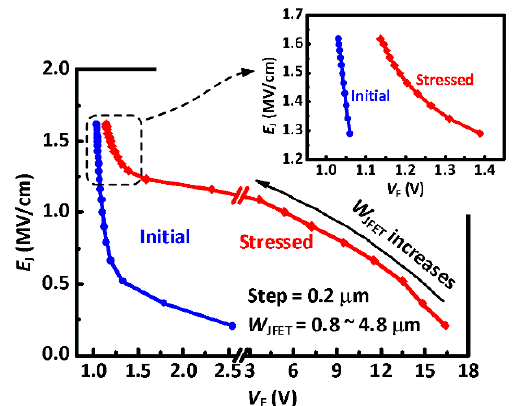
Figure 6. Illustration of the charge storing mechanism in the SiC JBS diode with Schottky contact to p-grid. Figure 7. The trade-off between Schottky junction field E J and the forward voltage V F in SiC JBS with a Schottky contact to p-grid.